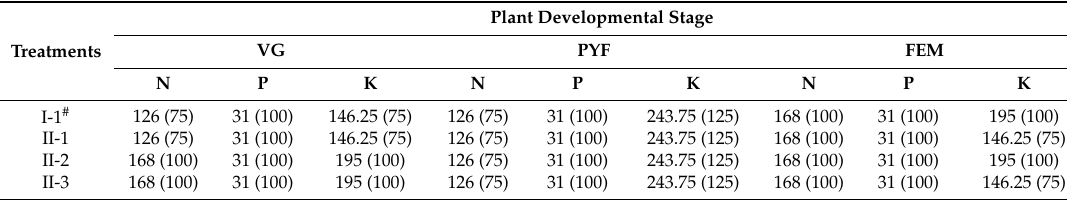
Table 2. Nutrient solution formulations of the four di ff erent treatments for the three developmental stages, including vegetative growth (VG), pollinated young fruit (PYF), and fruit enlargement and maturation (FEM) of hydroponic netted melon in Experiment II during spring–summer 2019. Nitrogen (N), phosphorus (P), and potassium (K) concentrations (percent) in mg /